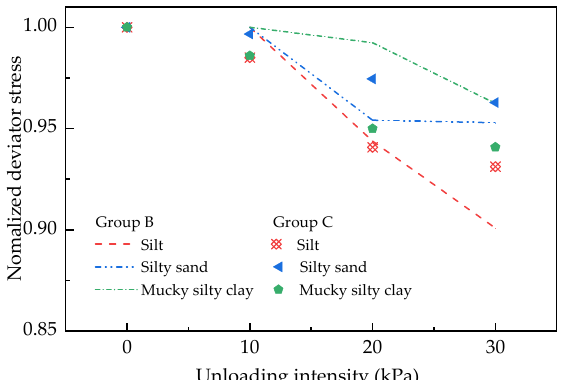
Figure 6. Normalized deviator stress–unloading intensity relationship of three soils under different stress paths.